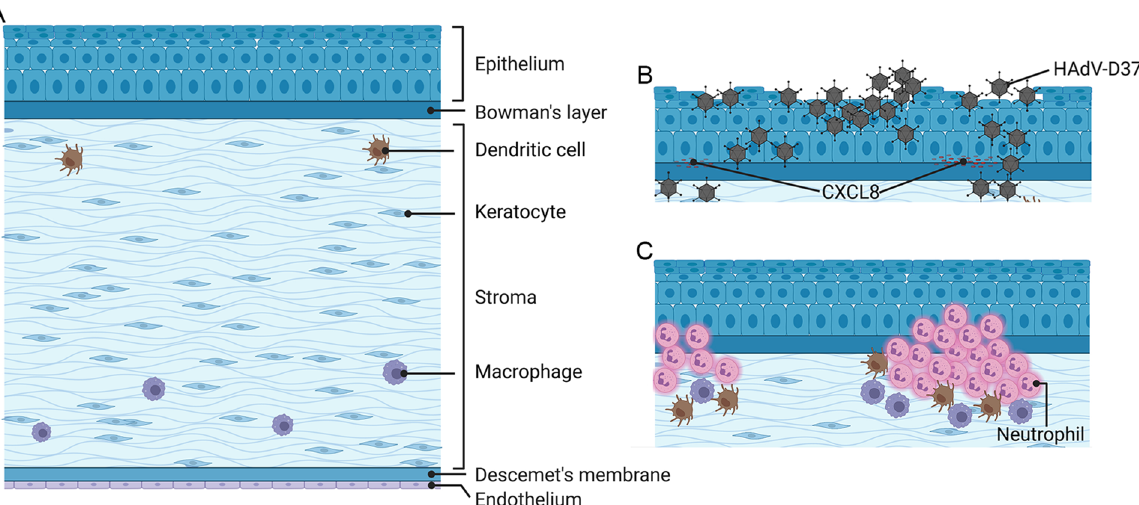
Figure 1. Schematic of the human cornea in cross-section. In the normal, uninfected eye ( A ), the central corneal epithelium is intact, and the corneal stroma is sparsely populated by fibroblast-like keratocytes and a smaller number of myeloid cells. In the cornea acutely infected by a cornea-tropic adenovirus ( B ), the corneal epithelium is disrupted by virus-induced cytopathic effect. Upon infection of superficial keratocytes, chemokines, e.g., CXCL8, accumulate in multifocal loci at the level of the corneal epithelial basement membrane. In a subset of infected eyes, after the epithelium has healed ( C ), neutrophils and other monocytes migrate from corneal limbal blood vessels to form multifocal, subepithelial infiltrates at foci of chemokine accumulation. Created with BioRender.com under a standard academic license.